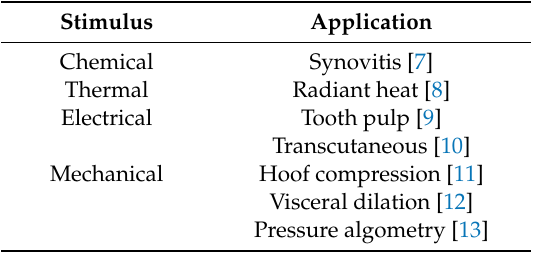
Table 1. Equine pain models and methods to assess nociception.